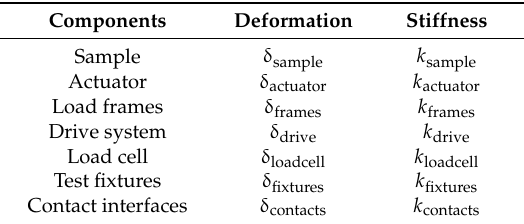
Table A1. Deformation and stiffness of components in the compression